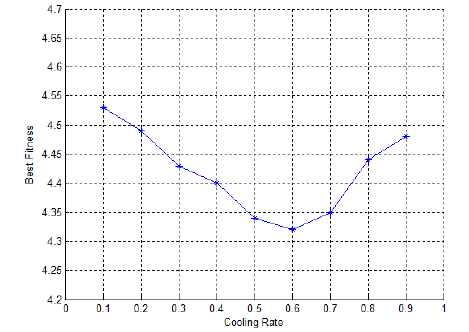
Figure 8. The best fitness value of the achieved routes over 100 independent runs under different cooling rates.